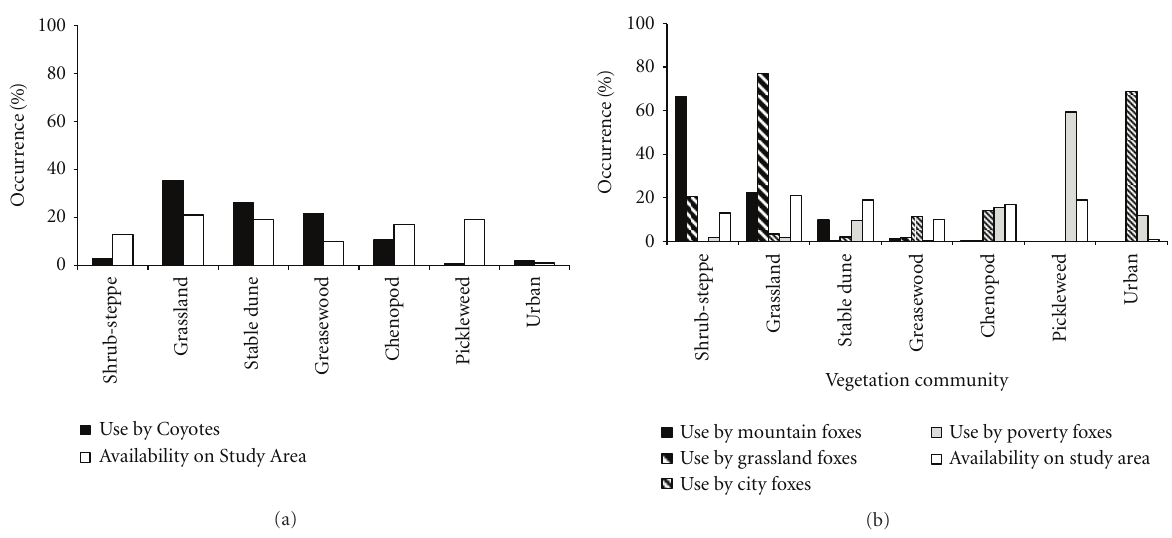
Figure 1: Comparison of habitat type availability and use by (a) all coyotes, and (b) kit foxes in mountain, grassland, city, and poverty landscapes, Dugway Proving Ground, Utah, 1999–2001. Table 1: Species and abundance of small mammals caught during 1999–2001, Dugway Proving Ground, Utah. PEMA: Peromyscus manic- ulatus , REME: Reithrodontomys megalotis , DIOR: Dipodomys ordi , ONLE: Onychomys leucogaster , NELE: Neotoma lepida , PETR: Peromyscus truei , AMLE: Ammospermophilus leucurus , DIMI: Dipodomys microps , PEPA: Perognathus parvus .